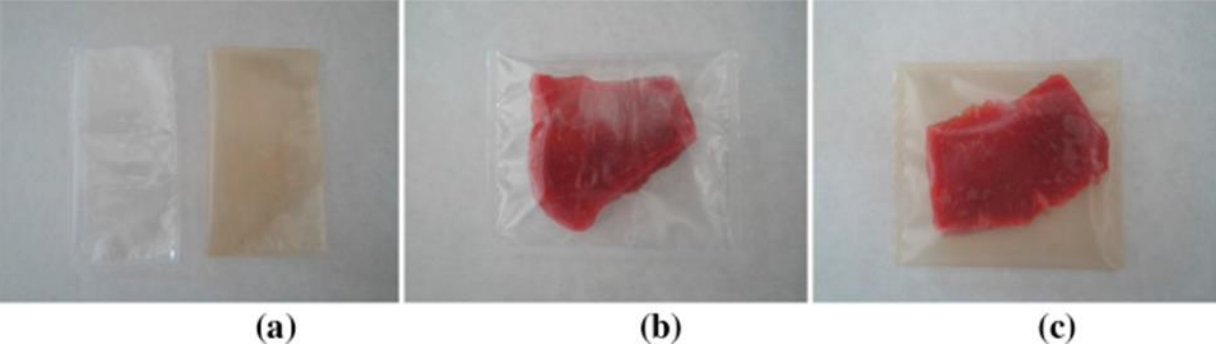
Figure 9. Comparative images of tested films ( a ); sample of meat packaged with blank film ( b ) and, with active film ( c ). Reproduced from ref. [95] with permission from Elsevier. 2015